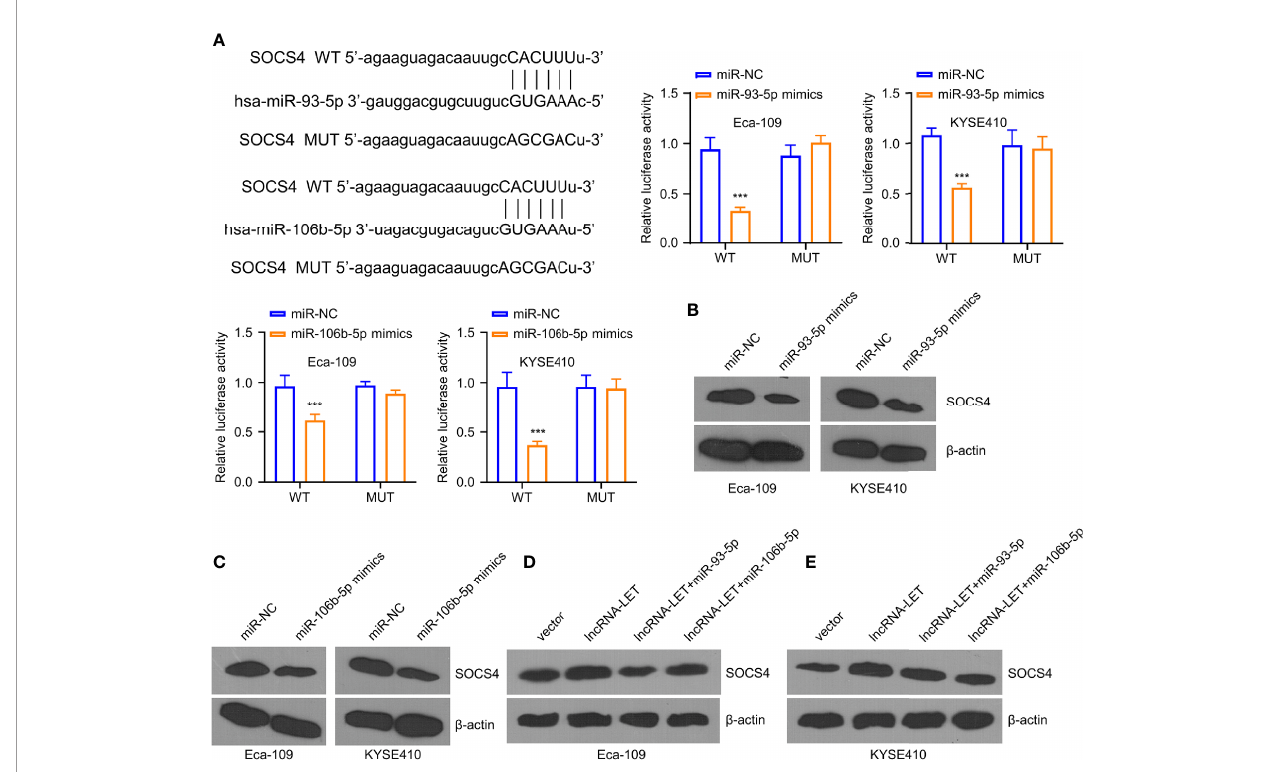
FIGURE 5 | miR-93-5p/miR-106b-5p regulate the levels of SOCS4. (A) The predicted binding sites for SOCS4 gene on miR-93-5p and miR-106b-5p were analyzed by the starBase database. Western blotting was used to determine (B, C) SOCS4 protein in cells subjected to miR-93-5p or miR-106b-5p transfection and (D, E) in cells transfected with vector, lncRNA-LET, or lncRNA-LET+miR-106b-5p or miR-93-5p, respectively. * P < 0.05, ** P < 0.01, and *** P <